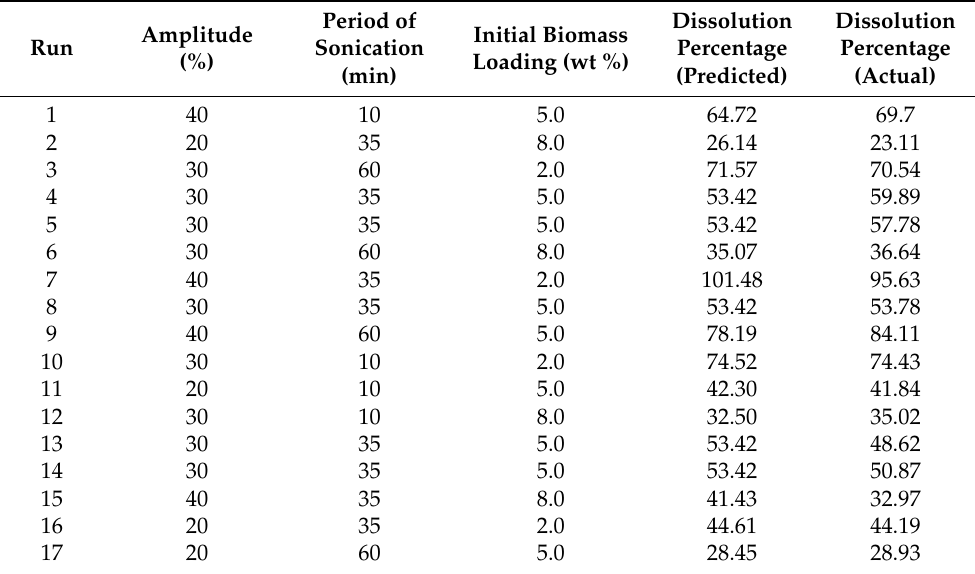
Table 5. Predicted vs. actual value for bamboo dissolution in 1-2(methoxyethyl)-3-methylimidazolium chloride